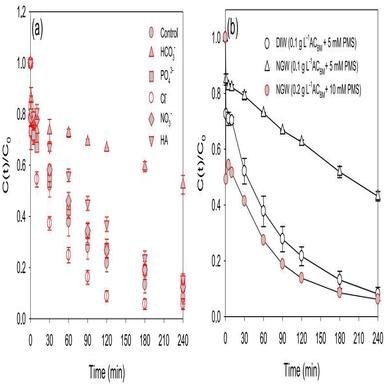
Effects of anions (a) HCO3 − , PO4 3− , Cl− , NO3 − , and Humic acid (HA), and (b) effect of water matrix on IBP degradation in the ACBM/PMS system. (Experimental conditions: = 0.1 mmol L− 1 , = 5 and 10 mM, = 0.1 and 0.2 g L–1 , = 6.3, = = = = 10 mM, and = 10 mg L–1 ).